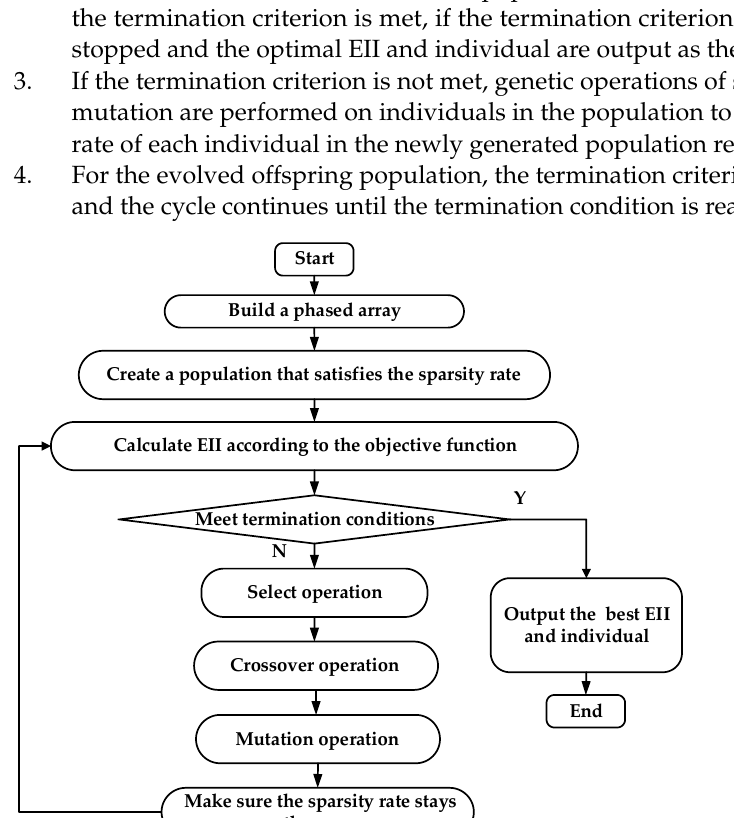
Figure 2. The flow chart of sparse ALSTAR arrays.